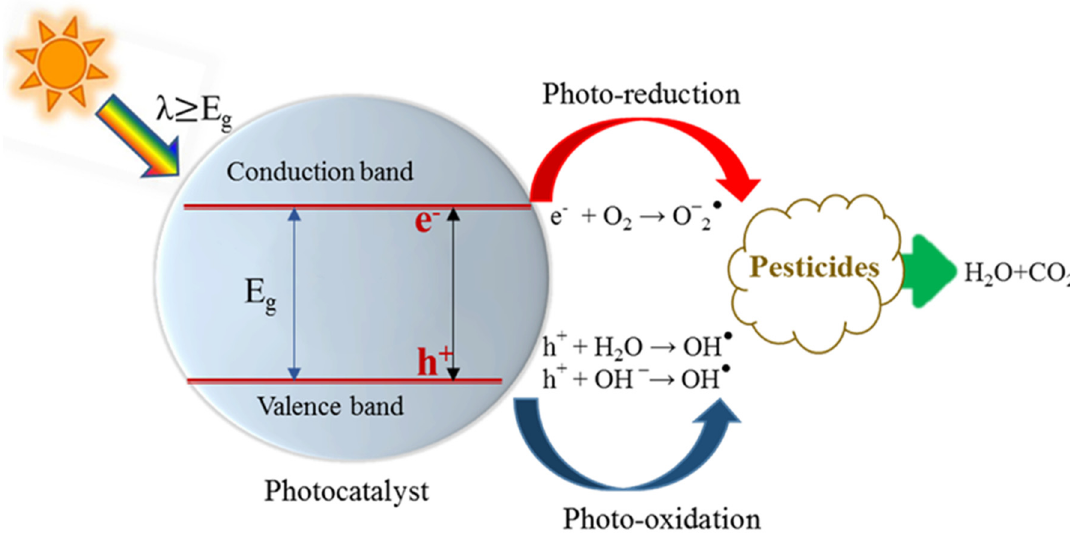
Figure 6. Scheme of photocatalytic degradation mechanism of pesticides on TiO 2. Upon irradiation, the semiconductor photocatalyst absorbs electromagnetic UV radiation. The photons with energy equal or greater to its band gap are absorbed by the photocatalyst. For the TiO 2 , UV absorber and the band gaps are typically 3.2 eV for anatase or 3.0 eV for rutile [29]. After light absorption, the photocatalyst becomes excited, i.e., excitons are generated then the electrons are excited from the valence band into the conduction band. (Equation (1)). This process creates photo excited positive holes in the valence band. These excited charge carriers must diffuse though the bulk to the surface of the photocatalyst. If they successfully reach the surface, the holes will oxidize the pre-adsorbed donor molecule (D) into D + and the electrons will reduce the adsorbed acceptors (A) into A- [29,38]. The most common donors are mainly the water H 2 O or hydroxyl ions adsorbed on surface. They get oxidized with the holes to generate the highly reactive hydroxyl radicals ( • OH) according to (Equations (2) and (3)) [39]. The excited electrons will reduce adsorbed pesticides on the surface of the photocatalyst. The most common electron acceptor is the O 2 which gets reduced into the superoxide radical O ·− (Equation (4)) [40]. These generated hydroxyl radicals and superoxide radical anions are the major oxidizing agents that drive the photocatalytic oxidation processes of the pesticide residues. These radicals attack the pesticide molecule and decompose it to mineral ions and other products eventually, i.e., CO 2 and H 2 O (Equation (5)). However, it is important to mention that the generated electrons and holes may